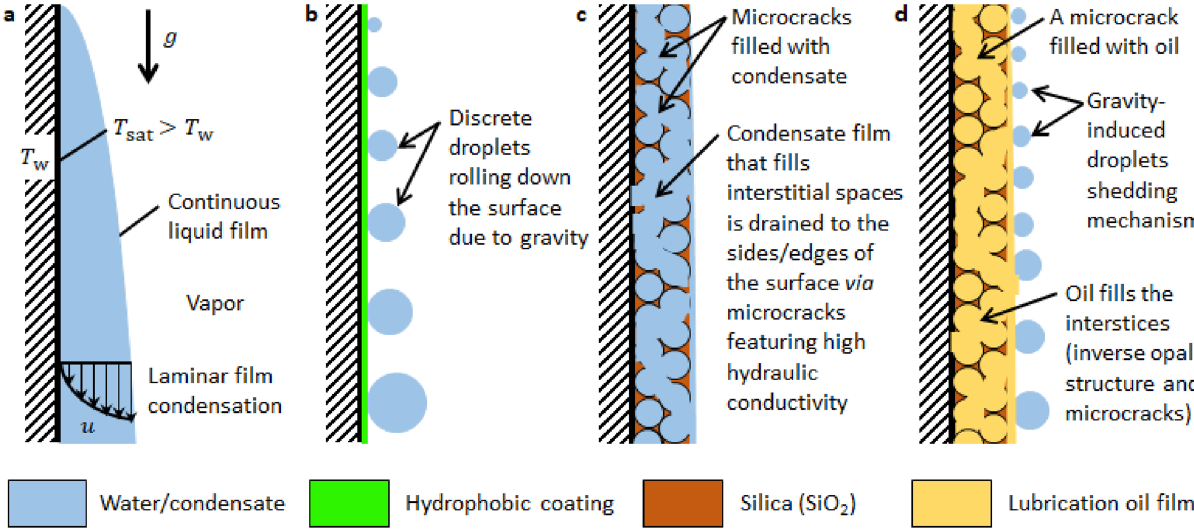
Figure 1. Schematic depictions of different modes of condensation. ( a ) Filmwise condensation (FWC) where the condensate forms a continuous liquid film on a chemically clean (high surface energy) surface. The wall is maintained at a lower temperature ( T w ) than the surrounding saturated vapor ( T sat ). The temperature and velocity profiles are shown for laminar film condensation where the flow-rate based Reynolds number is < 30. ( b ) Dropwise condensation (DWC) on hydrophobic (low surface energy) surface. It is essential for dropwise condensation that some promoter material, for example organic compound, be present on the surface. Periodic removal of large droplets clears the surface for renewed droplet nucleation and growth. ( c ) Inverse opal condensation (IOC) on a porous inverse opal structure. Condensate seeps into the porous structure by displacing the air in the pores. Preferential condensate transport through high hydraulic conductivity micro cracks improves the heat transfer rate. ( d ) Condensation on a slippery liquid-infused porous surface (SLIPS). The porous interstices are impregnated with a chemically matched oil. Compared to DWC, droplets depart with smaller radius and higher frequency in SLIPS